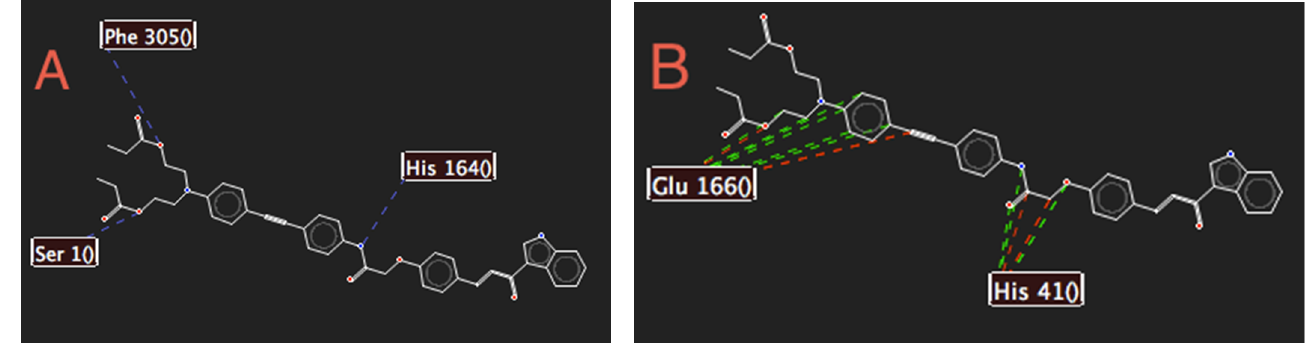
Figure 5. ( A ) Hydrogen bond and ( B ) electrostatic interactions between the SARS-CoV-2-M pro and 15 .